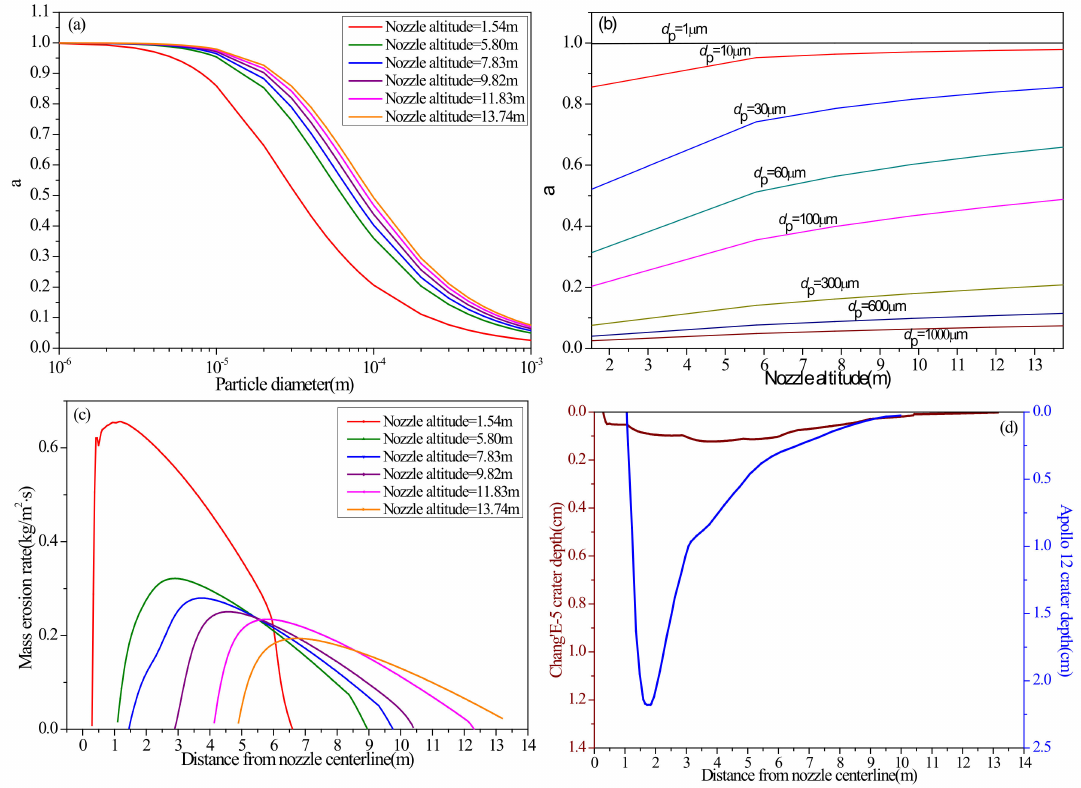
Figure 7. The parameter a , mass erosion rate, and crater depth of the Chang’E − 5 mission. Figure 8 illustrates the 4.84 µ m dust particles’ trajectories at different nozzle altitudes. The simulated particles are all injected at the six altitudes. However, the difference is that the higher the nozzle altitude, the lower the particles are, which is reasonable, due to a smaller shear stress at a higher altitude. The particles are blown away in the radical direction, and are finally no longer visible in the landing photo. The injected height for 1.54 m is much higher than for other distances, and thus the particles’ inclined angle is much larger as